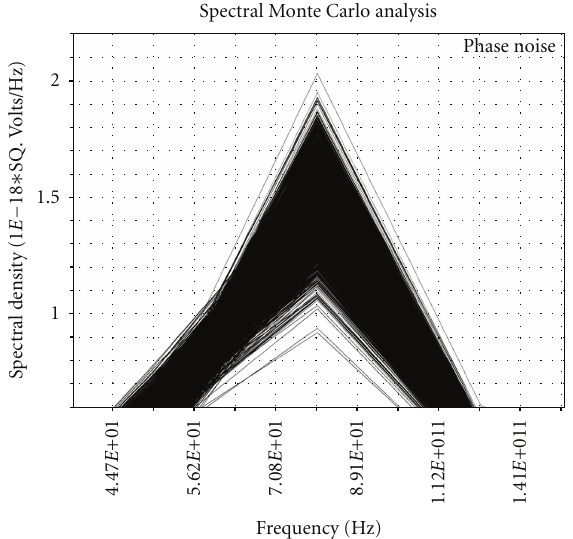
Figure 14: Monte Carlo simulation of phase noise “skirt” near a center frequency of ≈ 77 GHz for the proposed bu ff er cell oscillator.